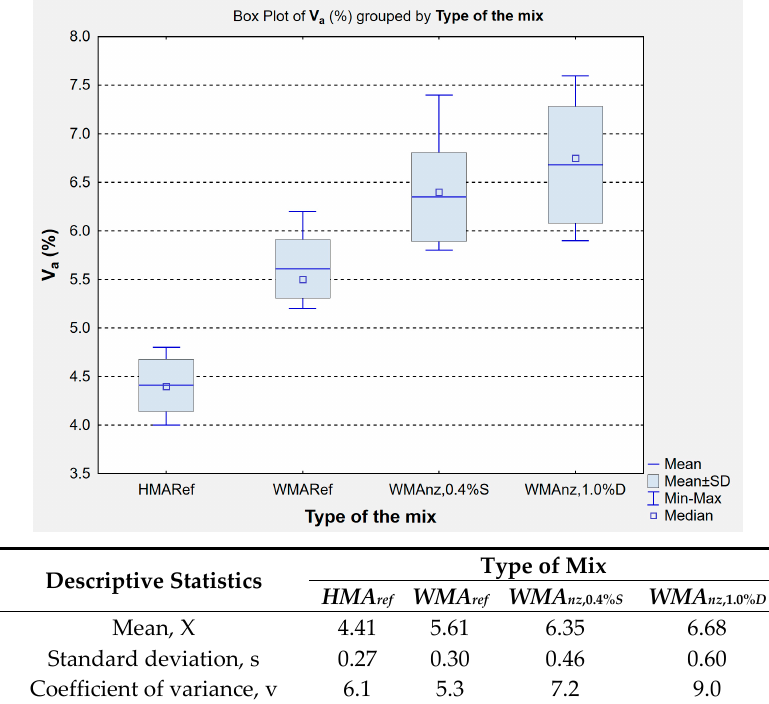
Figure 10. Results of air void content ( V a ) determination in Marshall samples produced from the investigated AC 16 mixtures.